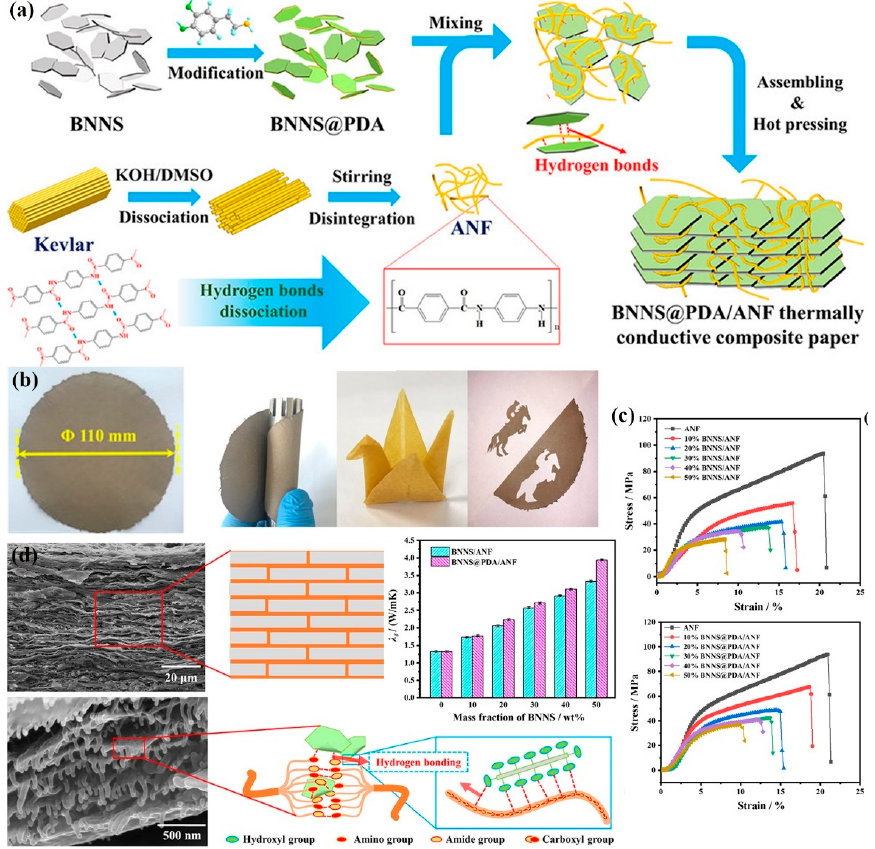
Figure 13. ( a ) Schematic illustration of the preparation of boron nitride nanosheet (BNNS)@PDA/aramid nanofiber (ANF) composites papers. ( b ) Photographs of BNNS@PDA/ANF composites papers. ( c ) Tensile stress–strain curves of BNNS/ANF and BNNS@PDA/ANF composites papers. ( d ) Cross-sectional morphologies of 50 wt.% BNNS@PDA/ANF composites papers and in- plane thermal conductivity coefficient of composites papers (reproduced with permission from [141]).